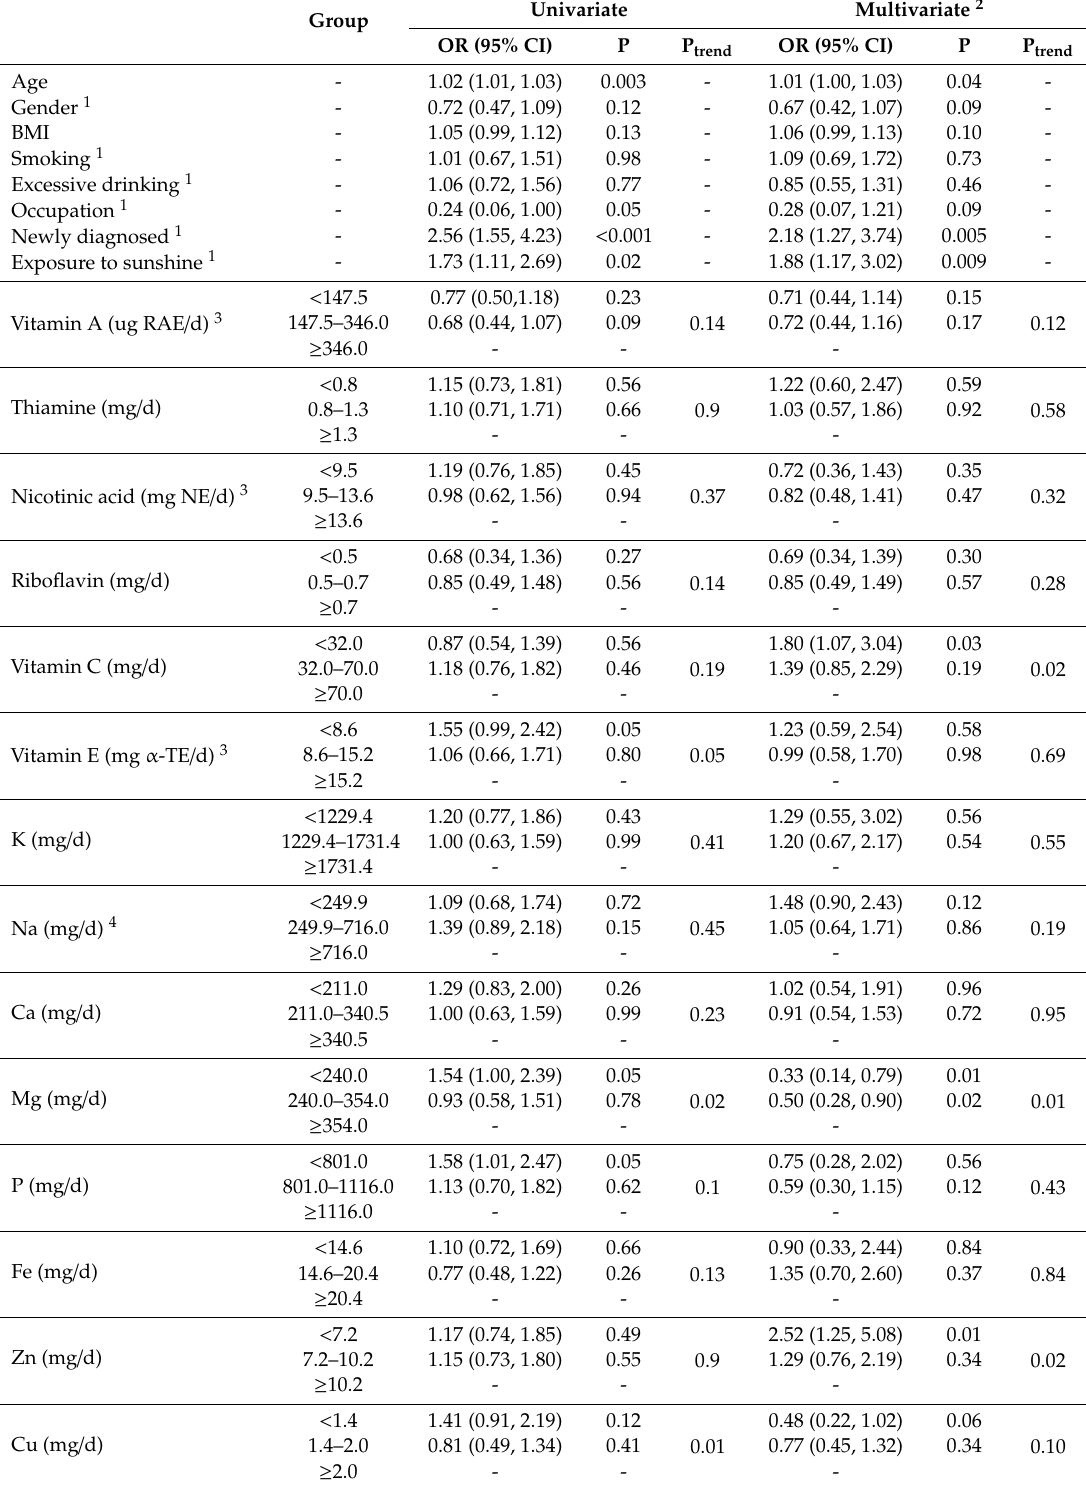
Table 2. Association of the dietary micronutrient intake with the failure rate of tuberculosis